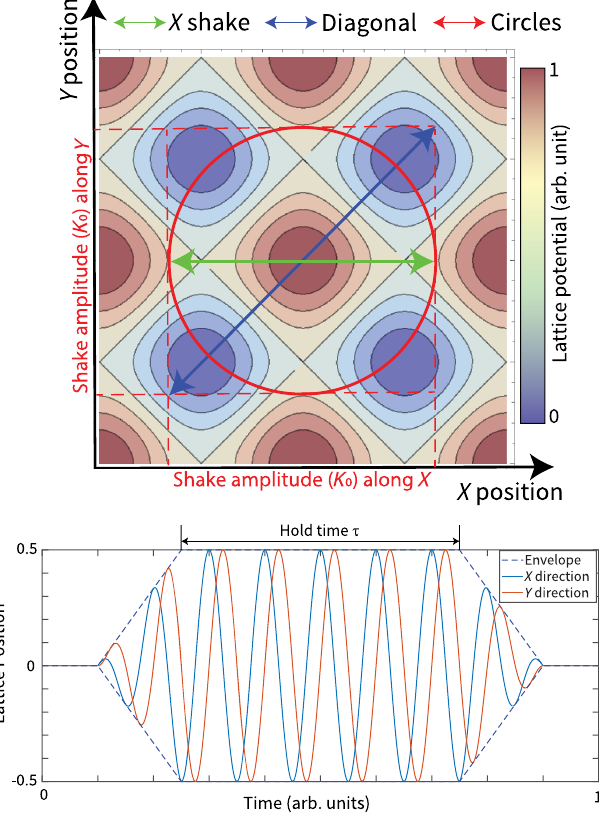
FIG. 1. Schematic of the lattice driving. (Top) Lattice trans- lation is performed along the x direction (green), along the diagonal (blue), and in circles (red). The normalized drive amplitude projected along the x axis, K 0 , is used to characterize the drive strength for all trajectories. (Bottom) Example of a periodic drive for circular